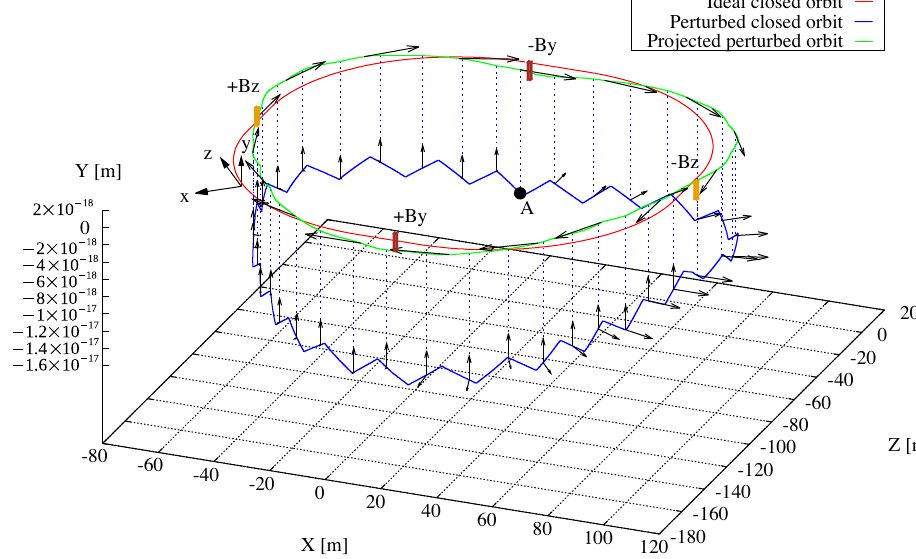
FIG. 6. Spin and orbit evolution for a lattice with alternating magnetic field imperfections: a vertical magnetic field yields a horizontal spin component which is rotated into the vertical plane by means of a longitudinal field component. The closed orbit of the perturbed motion is shown in blue and the particle motion is clockwise starting from point A. The orbit displacement from the ideal one is amplified for the sake of